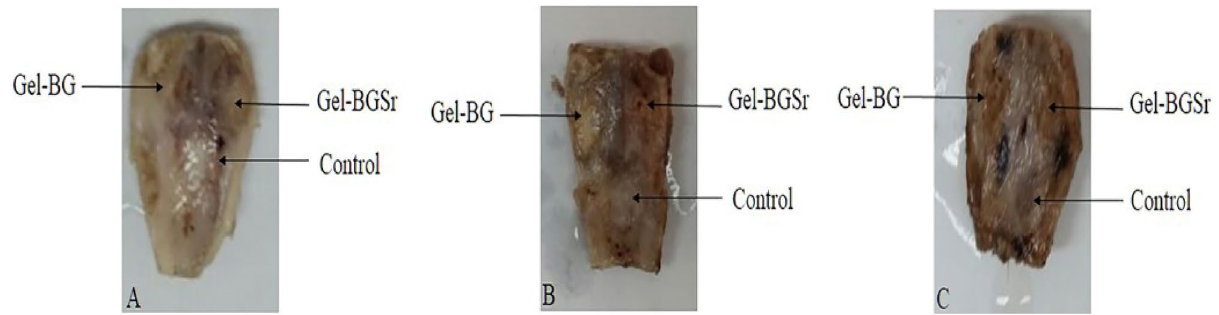
Figure 2. Macroscopic vault appearance of the defects, showing Gel-BG/Sr and Gel-BG scaffolds and Control (unfilled) after ( A ) 4; ( B ) 8 and ( C ) 12 weeks.